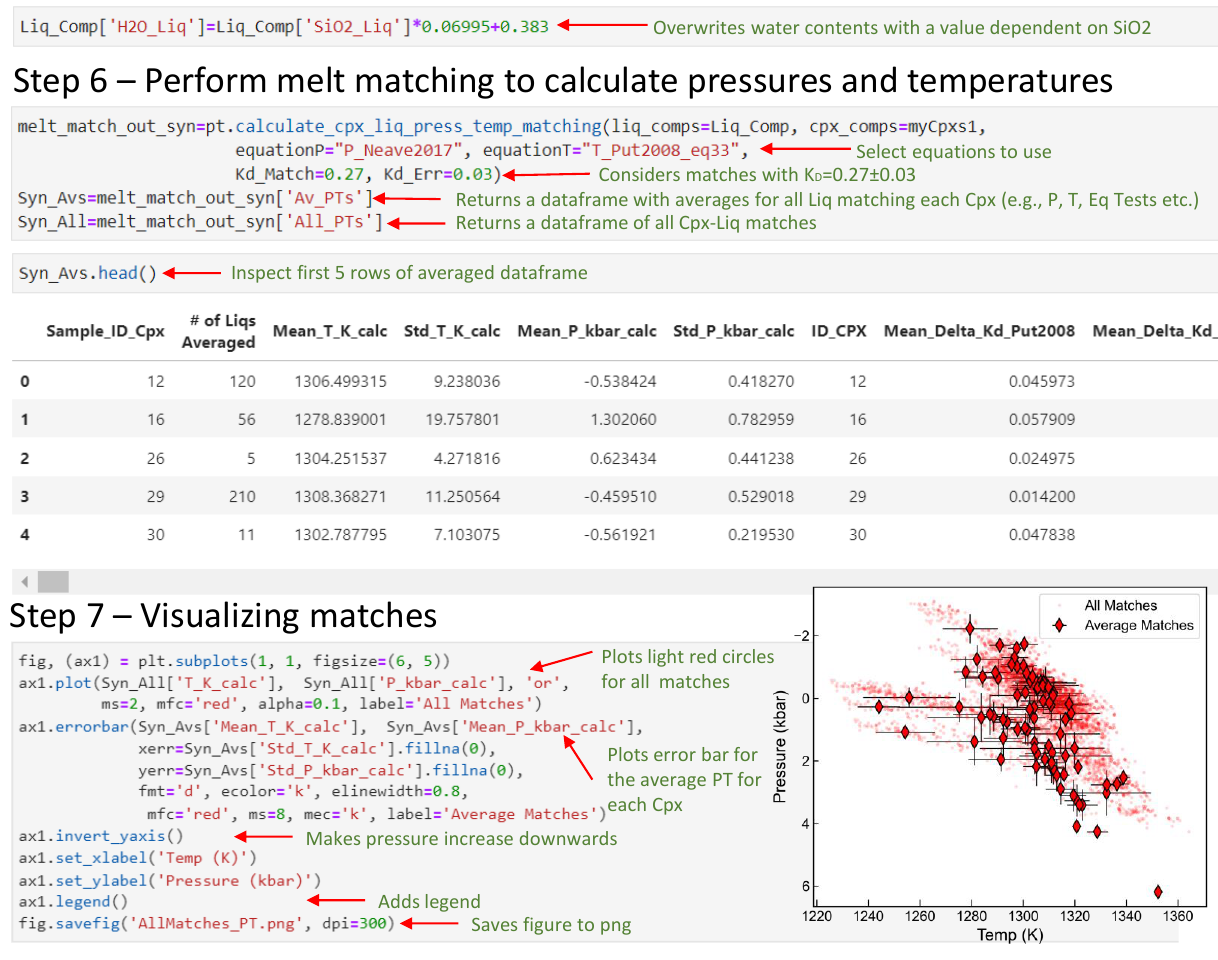
Figure 6: Step 4 : Once synthetic liquids have been calculated, users may wish to combine them with measured liquid composi- tions to get the largest number of available comparisons. Step 5 : Columns in this combined dataframe can be easily overwritten. Here, the liquid H O content is calculated from the SiO content of the liquid (following [Scruggs and Putirka 2018]). Step 6 : 2 2 Once the liquid input is set, the function calculate_cpx_liq_press_temp_matching is called, specifying the choice of liquid and Cpx compositions, as well as the equation for pressure and temperature. The function returns a dictionary, which can be subdivided into a pandas dataframe containing all matches, and a dataframe where pressures and temperatures have been av- eraged for all the liquids in equilibrium with a given Cpx composition. Step 7 : Plotting both outputs gives insight into the amount of scatter associated with each Cpx-Liq pair compared to averaged